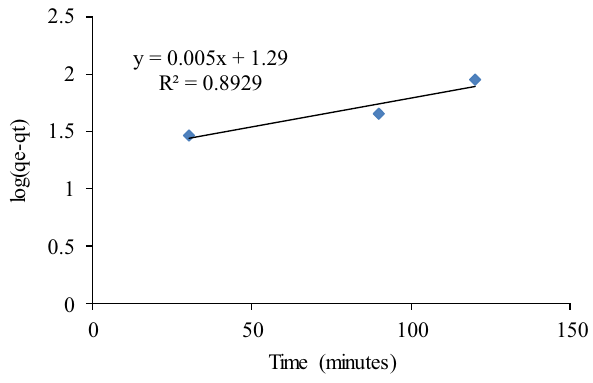
Fig. 9 Pseudo first order kinetic model for the sorption of Fe(III)on Fe(III)-IIP